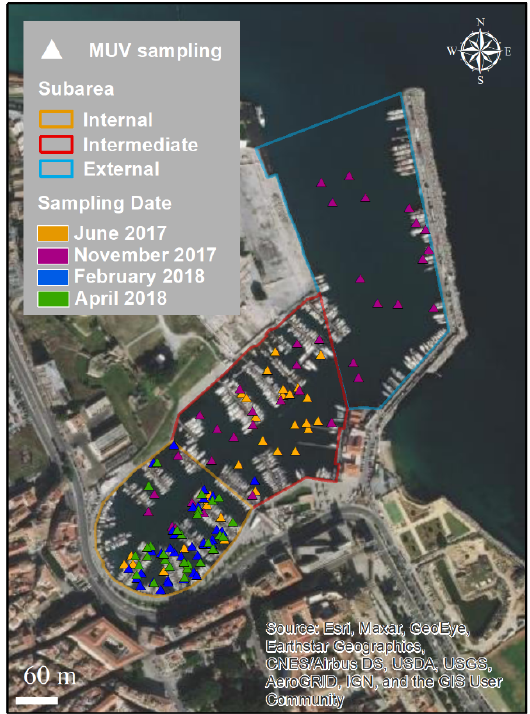
Figure 4. Sampling points per date using MUV within Cala.